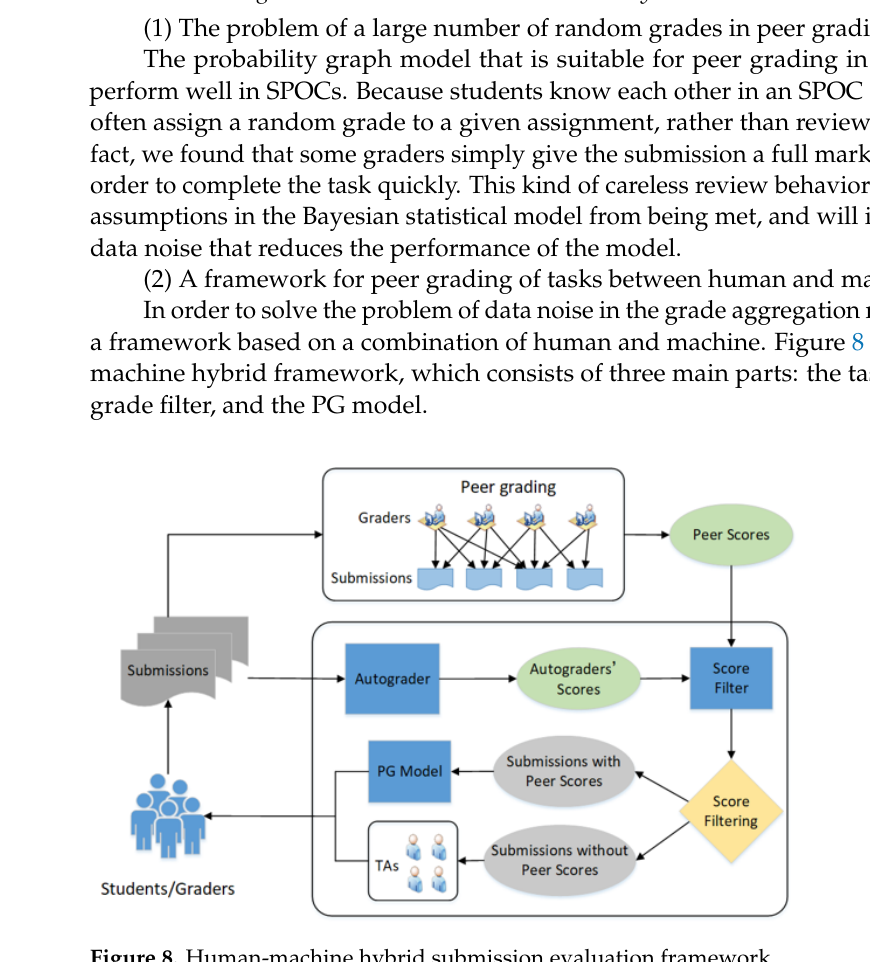
Figure 8. Human-machine hybrid submission evaluation framework.